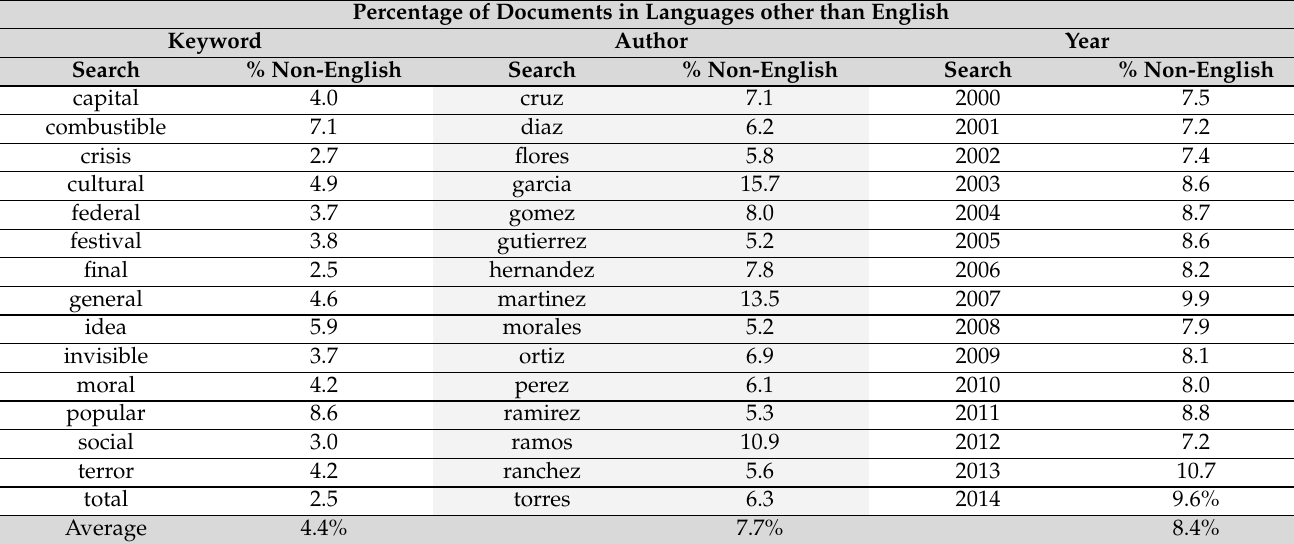
Table 1. Sample of searches carried out and the percentage of documents retrieved written in languages other than English. Percentage of Documents in Languages other than